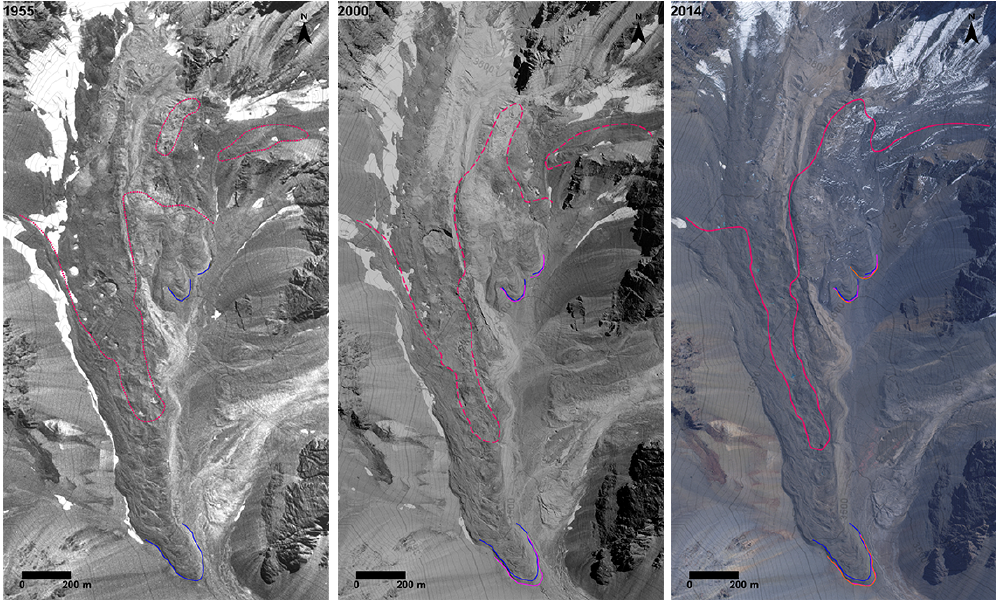
Figure 6. Sequence of orthophotos obtained for Navarro. The base of the landform front that could be reliably identified is indicated in colour (blue, magenta, and orange line in 1955, 2000, and 2014, respectively). At each date the boundary between debris-covered and rock glacier morphology is depicted with a red line (dotted in 1955, dashed in 2000, continuous in